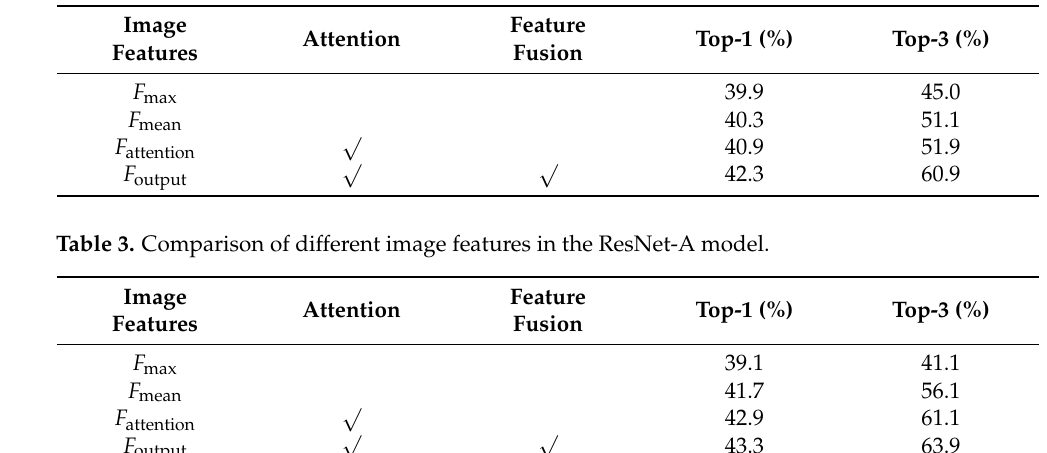
Table 2. Comparison of different image features in the VGG-A model.